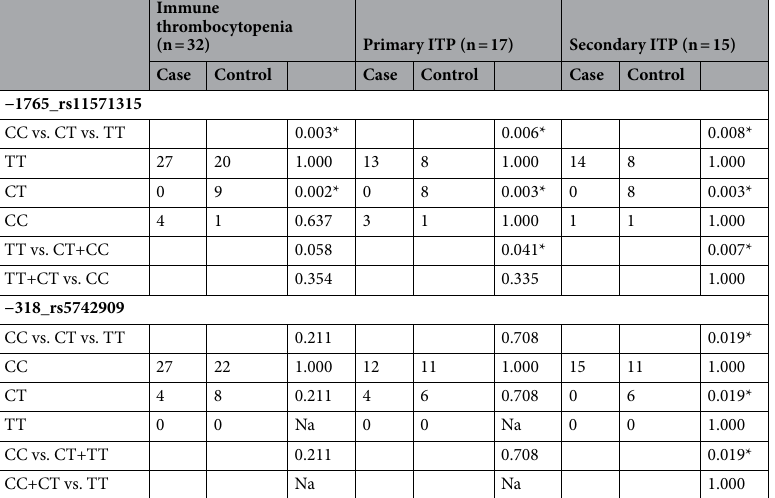
Table 4. The immune thrombocytopenia (ITP) cases were divided into primary ITP without underlying disease and secondary ITP caused by autoimmune disease to confirm the correlation between CTLA4 SNPs and each ITP group. “*” means that it had significant difference between test group and control group. The same group of controls (n = 17) was used to analyze the correlation between controls and the primary ITP and secondary